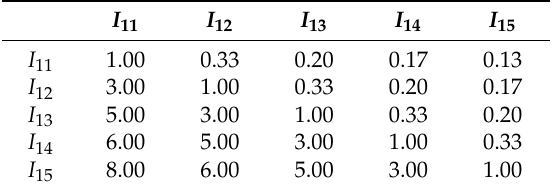
Table A2. Judgment matrix of the initiating process index.